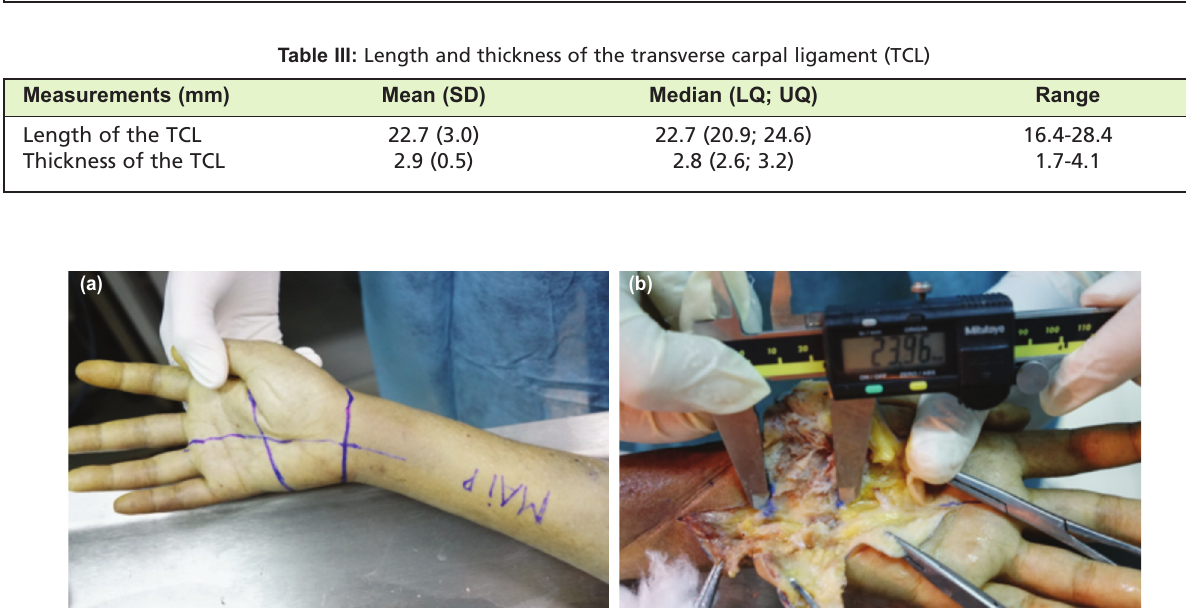
(a) The drawn lines. (b) Measuring the length of the transverse carpal ligament. Fig. 1: